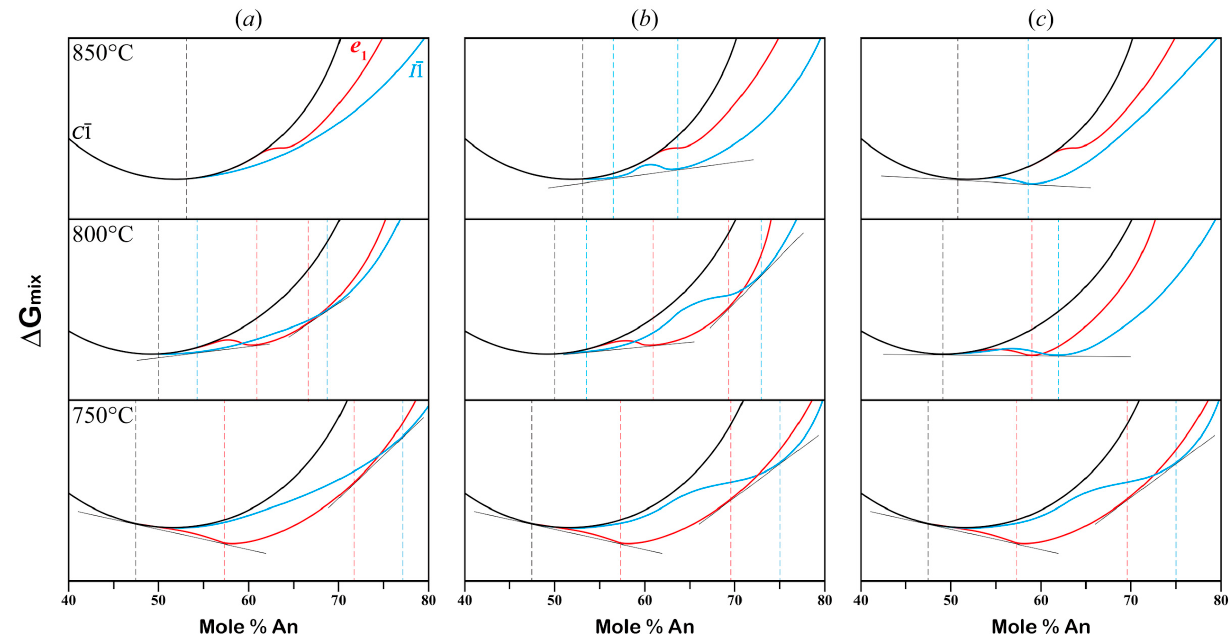
Figure 11. Schematic G-X curves of the C 1 (black), e 1 (red), and I 1 (cyan) phases around the I 1 / e 1 transition temperature. ( a ) The I 1 curve is of a simple convex shape within the composition and temperature range; ( b ) the I 1 curve results in a solvus within the I 1 phase; ( c ) the I 1 curve results in a coexisting area between the C 1 and the I 1 structures.